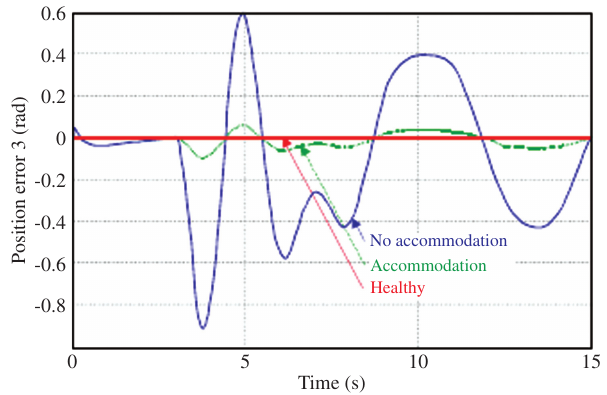
Figure 12. Position Error 3 with Defect at t = 3.5 s.